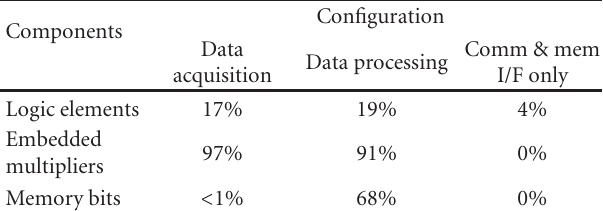
Table 3: Computing FPGA